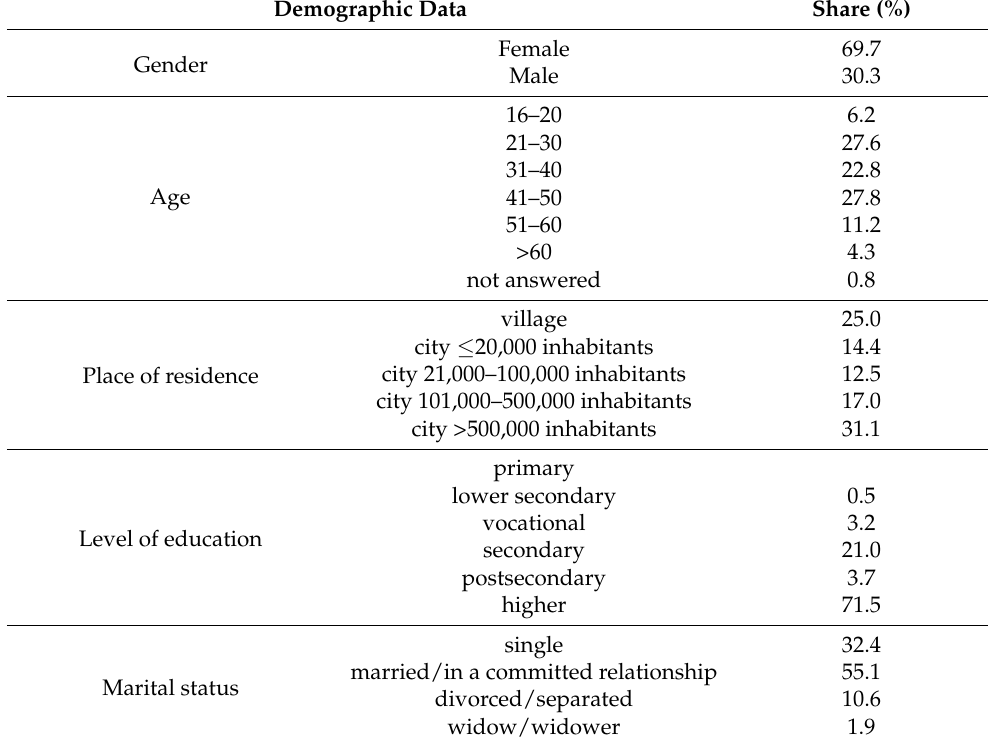
Table 1. Some additional descriptive statistics for stress coping strategies can be found in Appendices A and B. Table 1. Sociodemographic characteristics of the respondents (share